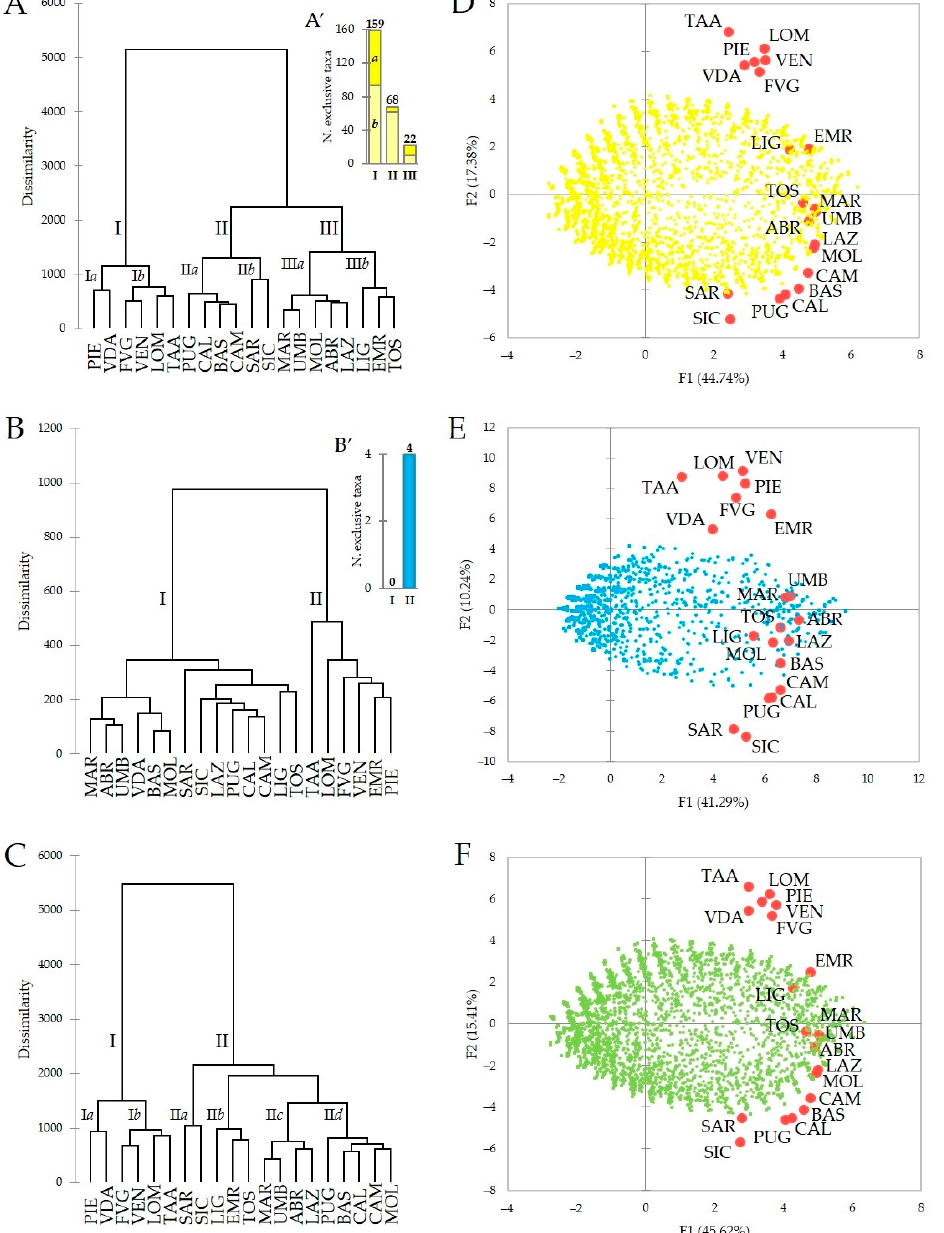
Figure 5. Dendrogram of the agglomerative hierarchical clustering ( A , B , C , with an indication of the main groups and subgroups) and biplot of the principal component analysis in the first two principal components space ( D , E , F ) of current flora of the Italian administrative regions considering only native taxa ( A , D ), only alien taxa ( B , E ) and the total taxa ( C , F ). Histograms show the number of exclusive native ( A’ ) and alien ( B’ ) taxa of the main clusters (the complete list are available in Table S5). Taxa reported by mistake and as doubts, extinct and no longer recorded after 1950 are not counted (ABR: